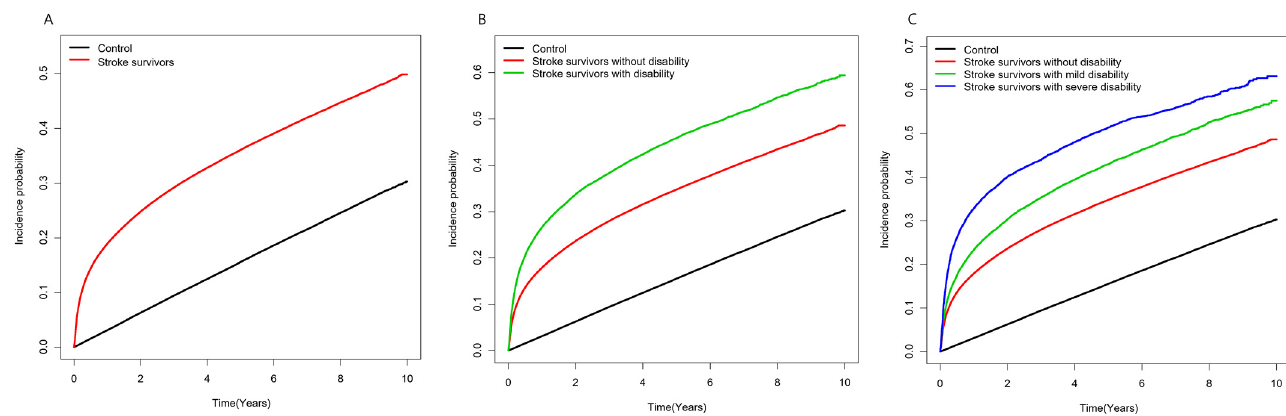
Figure 2. Incidence probability of the depression in ( A ) stroke survivors and control group ( B ) stroke survivors with disability, without disability, and control group; ( C ) stroke survivors without disability, with disability by the severity degrees, and control group. Table 3. Comparison of the risk of developing depression in stroke survivors and matched control group.